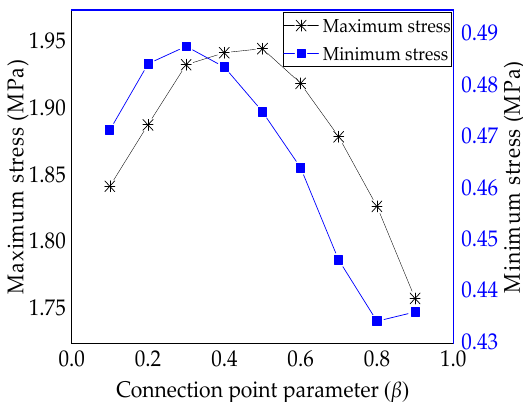
Figure 9. Maximum-minimum equivalent stress of variable-angle laminates of [0 ± < 20 ( β ) 60 > ] 2s with connection point parameter β .